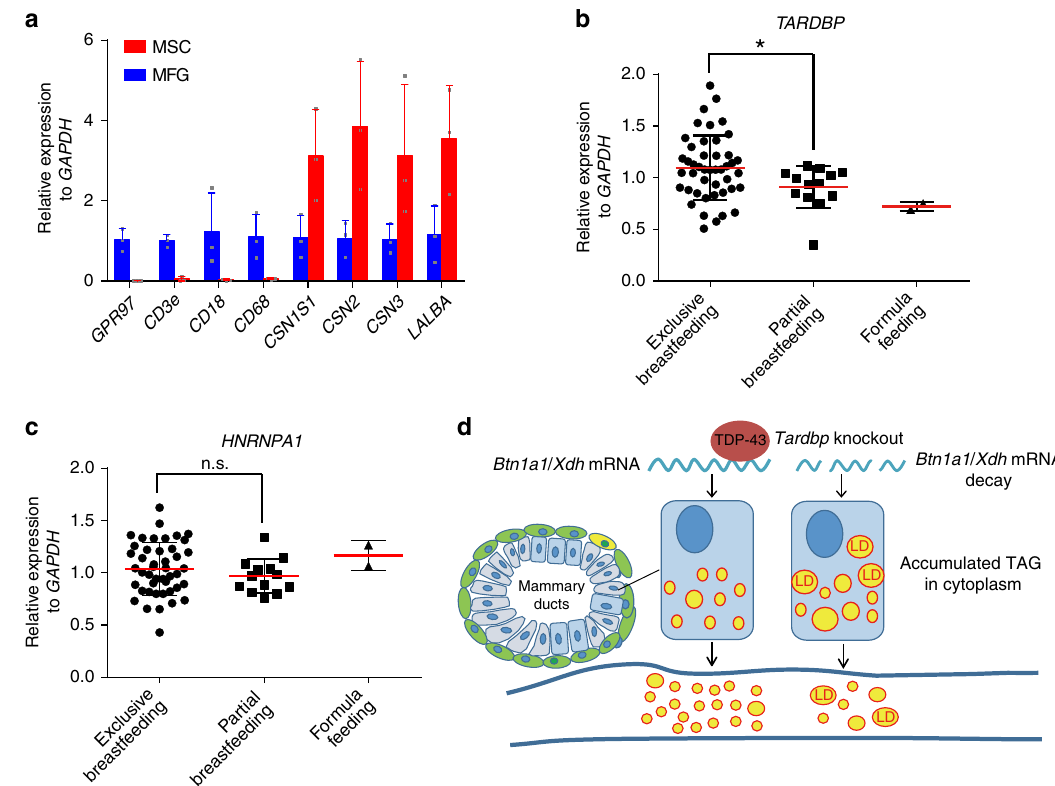
Fig. 8 Low TDP-43 expression relates to human lactation de fi ciency. a Quanti fi cation of mRNA expression levels of cell-speci fi c markers in MSCs (milk somatic cells, n = 3) and MFGs (milk fat globules, n = 3). MSCs were obtained from fresh human breast milk by centrifugation. Speci fi c markers for polymorphonuclear neutrophils ( CD18 and GPR97 ), lymphocytes ( CD3e ), macrophages ( CD18 and CD68 ), and MEC genes encoding milk proteins ( CSN1S1 , CSN2 , CSN3 , and LALBA ) are shown. b , c qRT-PCR analysis of TARDBP ( b ) and HNRNPA1 ( c ) mRNA expression levels in MFGs of fresh human milk on days 3 – 5 postpartum. Exclusive breastfeeding, n = 45; partial breastfeeding, n = 13; formula feeding, n = 2. d Graphic abstract of roles of TDP-43 in regulating milk lipid secretion. Data are means ± SD. Unpaired t test was used to evaluate statistical signi fi cance. * P < 0.05; n.s., not signi fi cant. Source data are provided as a Source Data fi